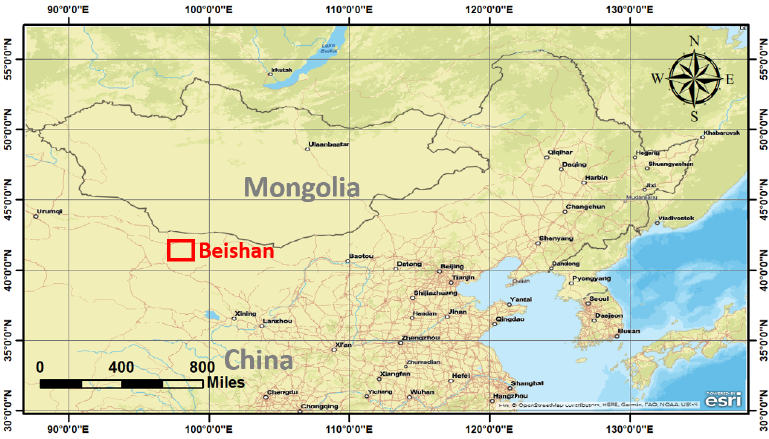
Figure 1. Location of Beishan area in Gansu Province, northwest China (highlighted by red box).